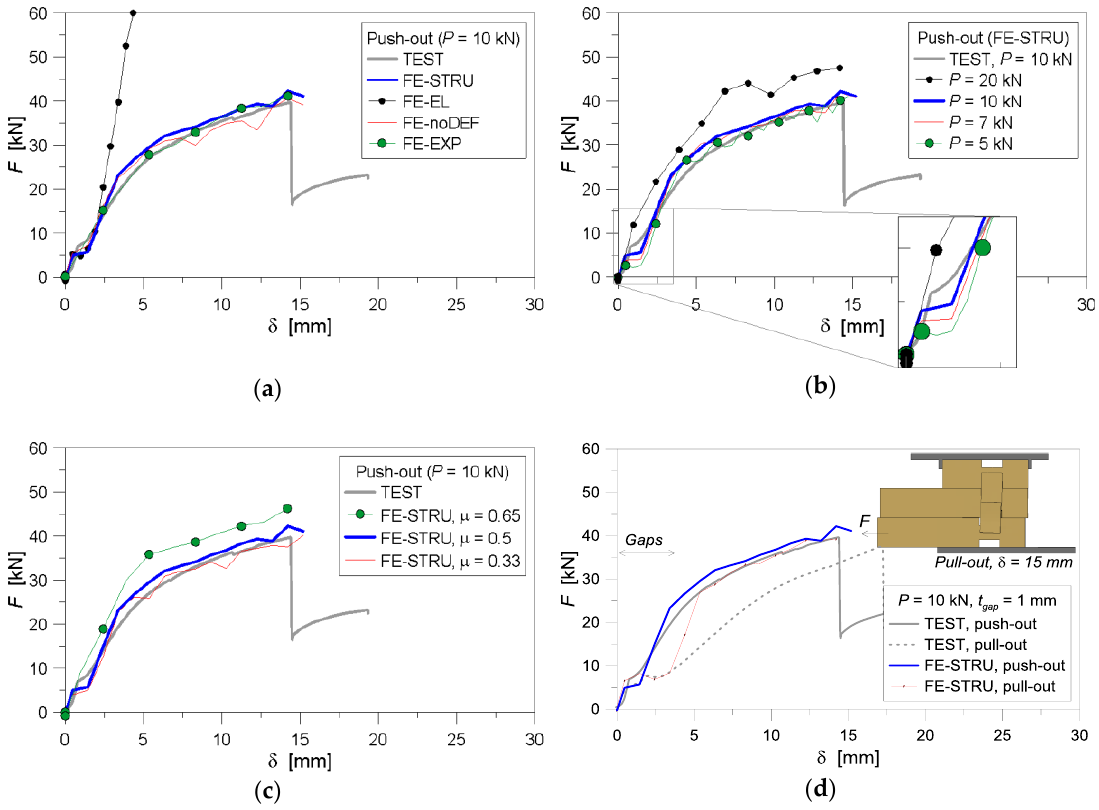
Figure 7. Load-displacement results for Standard joints, as obtained by changing ( a ) timber mechanical properties, ( b ) tightening level, ( c ) friction coefficient, and ( d ) loading configuration, with respect to the tolerance gaps (ABAQUS).